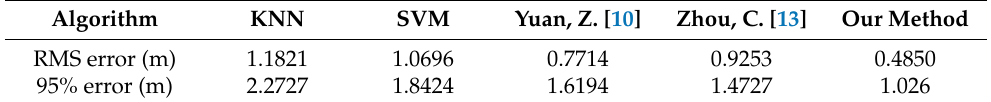
Figure 13. Cumulative Distribution Function of errors from different positioning algorithms. Table 3. Comparison of Location Accuracy of different fingerprint positioning